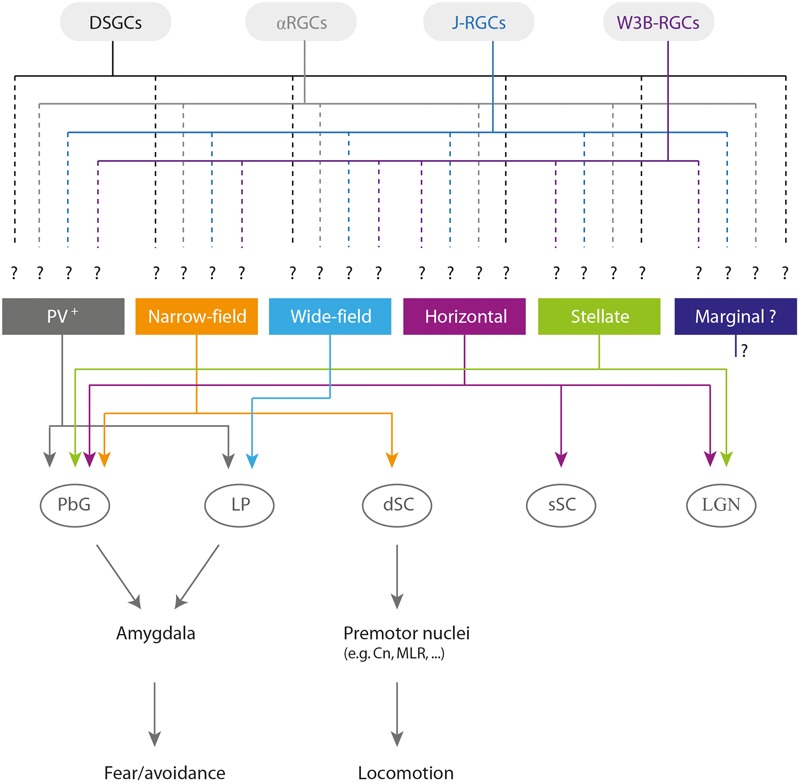
Overview of the sSC cell types (Gale and Murphy, 2014; Inayat et al., 2015; Shang et al., 2015, 2018), potential inputs from retinal ganglion cell types (Sanes and Masland, 2015), relevant output brain targets, and behavioral roles. Note that the identity of the retinal ganglion cells projecting to each collicular cell type remains unknown. Abbreviations: DSGCs, direction-selective ganglion cells; αRGCs, alpha retinal ganglion cells; J-RGCs, JAM-B-expressing OFF retinal ganglion cells; PV+, parvalbumin-positive neurons; dSC, deep layers of the superior colliculus; PbG, parabigeminal nucleus; LP, lateral posterior nucleus of the thalamus; sSC, superficial layers of the superior colliculus; LGN, lateral geniculate nucleus of the thalamus; Cn, cuneiform nucleus; MLR, mesencephalic locomotor region.